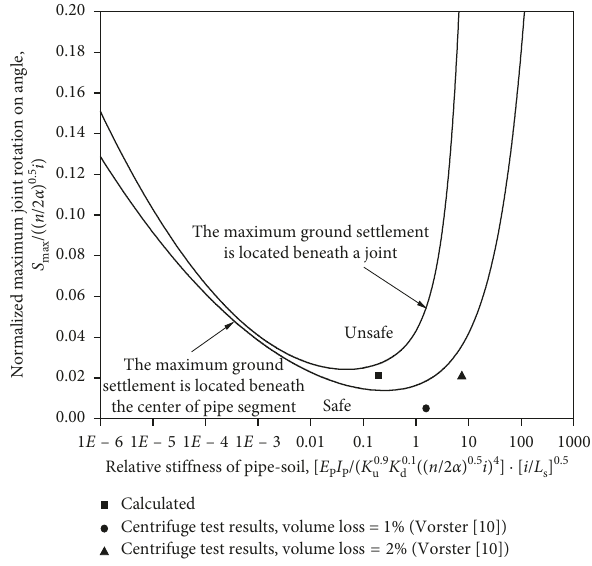
Figure 9: Illustration of the relationship between jointed pipeline safety criteria and the effects of